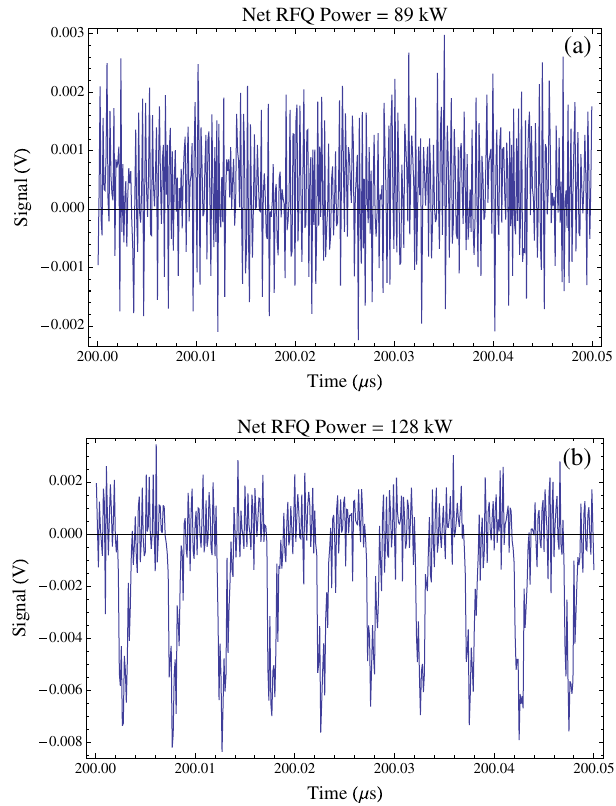
FIG. 29. The signal from the fast Faraday cup. (a) Below 100 kW of input rf power, there is clearly no bunching (b) at 128 kW, the beam is bunched.